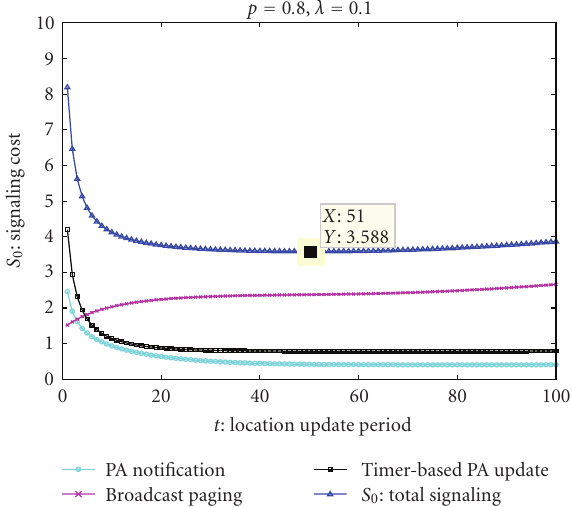
Figure 16: Signaling cost: low mobility and high message arrival